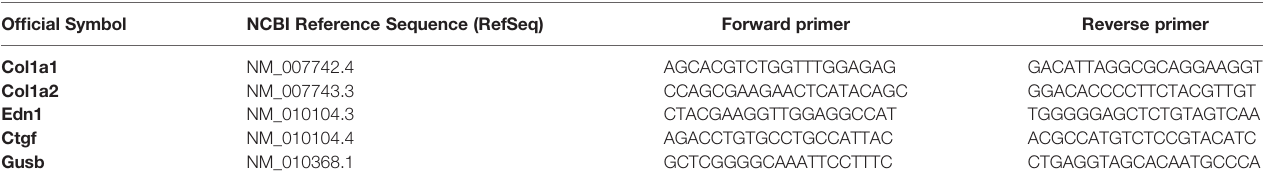
TABLE 1 | The primer list used for real time